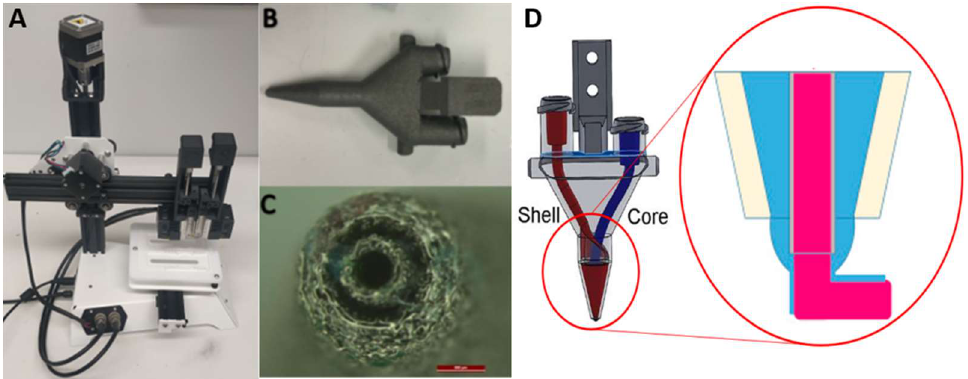
Figure 1. Custom made coaxial BioScribe 3D printer developed at TRICEP ( A ); 3D printer coaxial nozzle that allows for two syringes to be attached ( B ); Nozzle tip, comprised of an inner and outer orifice for the extrusion of the core and the shell components of the filaments, respectively. The scale bar represents 500 µm ( C ); Schematic drawing showing the channels inside the nozzle, being the core (red) used to extrude the supporting GelMA, while the shell (blue) is a softer coating of NSC-34 cells encapsulated in ColMA ( D ).